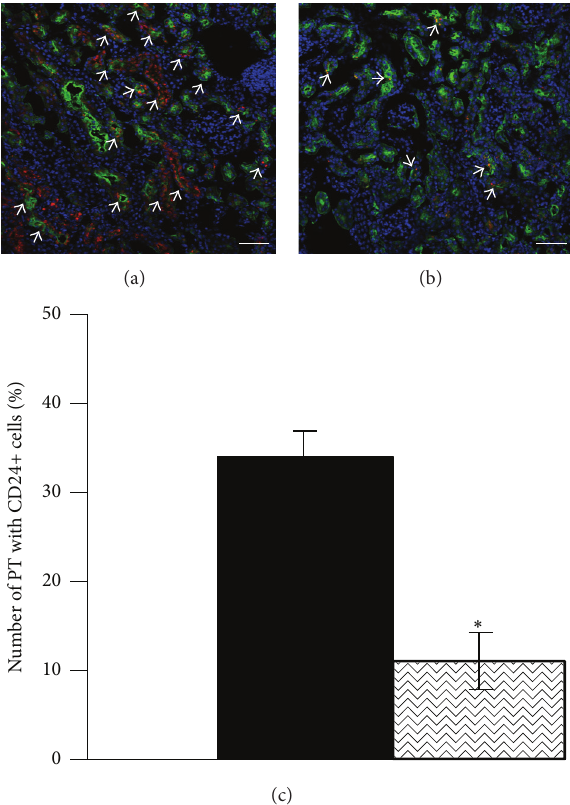
Figure 9: IWR-1 pretreatment of exogenous CD 24+ cells reduces integration into glycerol-damaged renal proximal tubules. CD 24+ cells were isolated by FACS from embryonic E15 mouse kidney and cultured for 12 hours in the presence or absence of IWR-1 (100 𝜇 M). 0.5 million CD 24+ cells were then labeled with PKH26 red dye and infused into mice three days after glycerol-induced proximal tubular injury. (a) Control CD 24+ cells (white arrows) are widely integrated into damaged proximal tubules stained with LTA (green); (b) proximal tubular integration (white arrows) of CD 24+ cells after IWR-1 pretreatment is strikingly reduced (a-b, scale bars: 50 𝜇 m). (c) The number of LTA-stained proximal tubules (PT) showing integration of PKH26 red CD 24+ cells was estimated in 310–340 tubules from 10 different kidney sections. Pretreatment of exogenous CD 24+ cells with IWR-1 (100 𝜇 M) reduced the percentage of tubules showing CD 24+ cells integration from 34% (control) to 11% (IWR-1). 𝑃 < 0.001